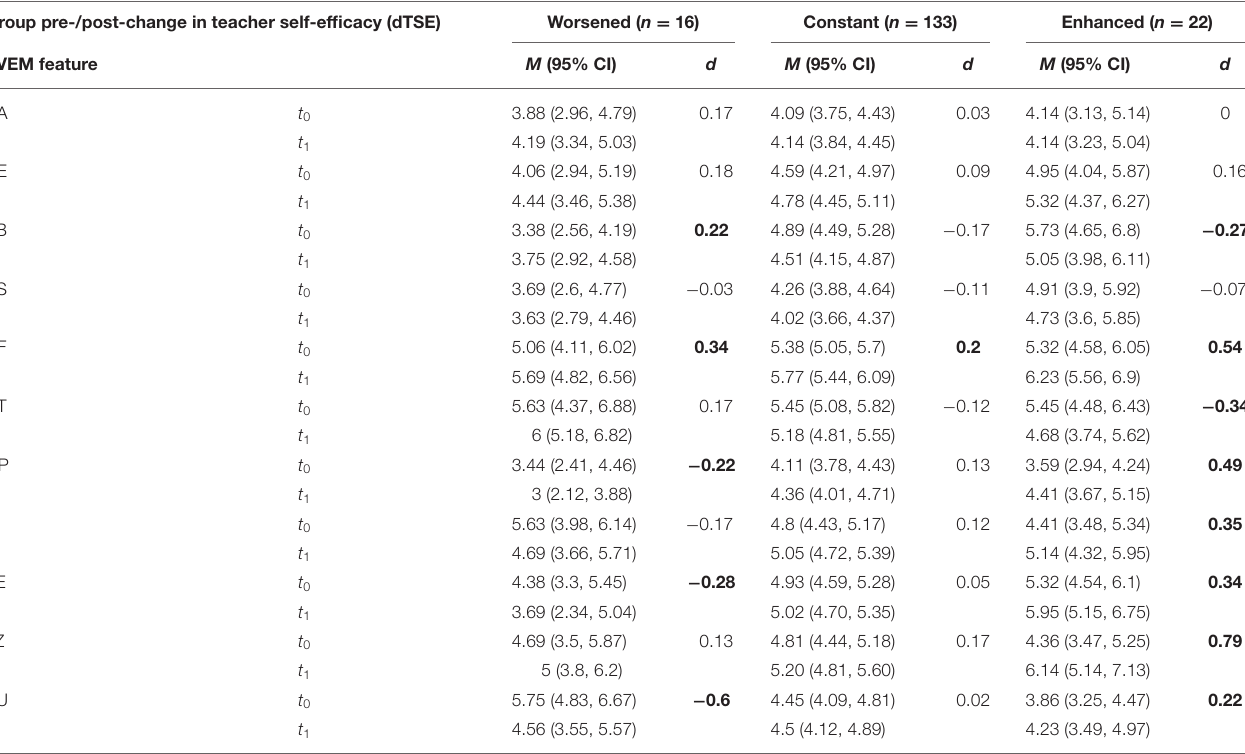
TABLE 2 | Means, estimated confidence intervals, and effect sizes for each AVEM feature at both measurement points (baseline t 0 and post-intervention t 1 ), within the groups of change in teacher self-efficacy pre- and post-intervention (worsened, dTSE ≤ M – 1 SD; constant, M – 1 SD < dTSE < M + 1 SD; enhanced, dTSE ≥ M + 1